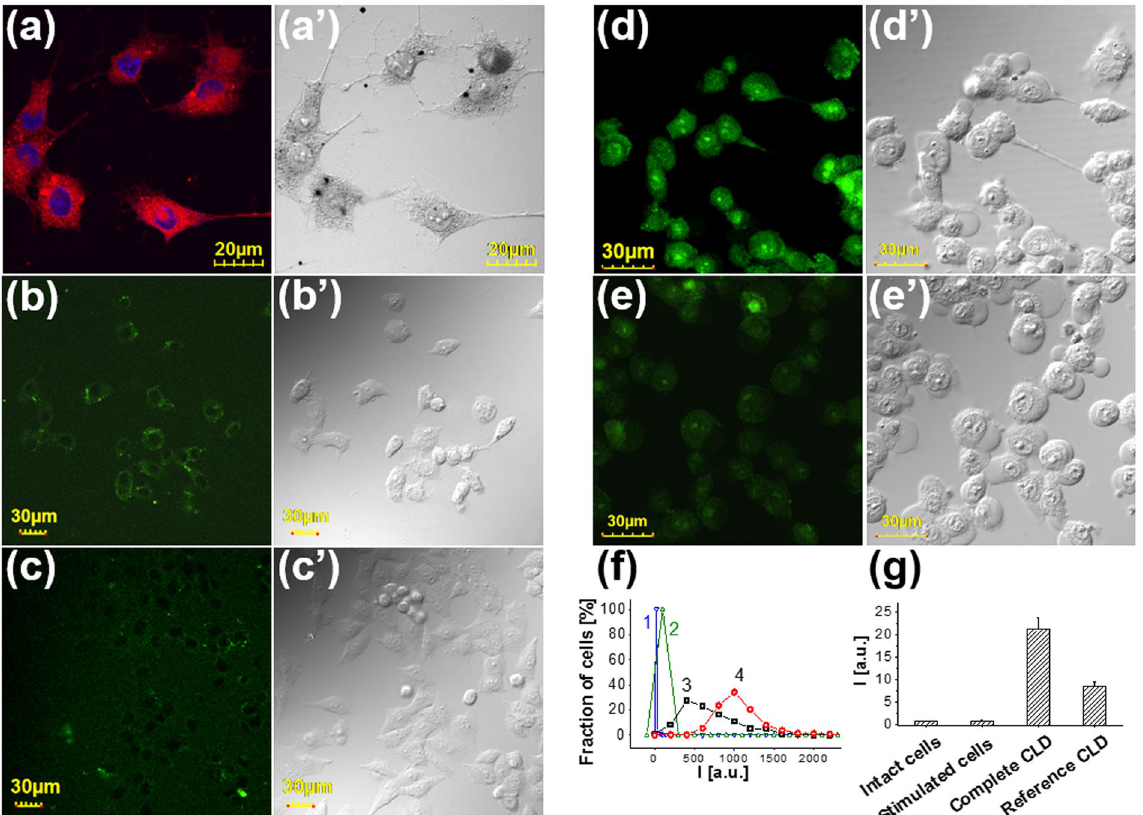
Figure 7. Intracellular localization of TMHP and oxidized SOSG in the cells treated with CLD. ( a ) LCSM image of the cells treated with complete CLD in the serum-free culture medium for 1 h at 37 °C and fixed with 4% formaldehyde in PBS. Nuclei were stained with 0.3 µ M DAPI. The left panel shows merged blue and red channels, the right panel shows differential interference contrast image. ( b – g ) Evidence for singlet oxygen generation due to PO-CL reaction in the cells. Confocal images of ( b ) intact cells, ( c ) the cells in the oxidative stress state, ( d ) similarly prepared cells treated with the complete and ( e ) reference CLD without TMHP. All samples were stained with 10 mM of SOSG ( f ) Distributions of the cells by the intensity of their fluorescence calculated from the analysis of at least 10 different images containing about 300 cells. 1 – intact cells, 2 – the cells under oxidative stress conditions, 3 – the cells prepared as in the sample (2) and treated with the complete CLD or 4 – with the reference dispersion without TMHP. ( g ) Measurement of SOSG endoperoxide fluorescence in the similarly prepared samples using plate fluorometer. Each sample contained about 0.2 millions of